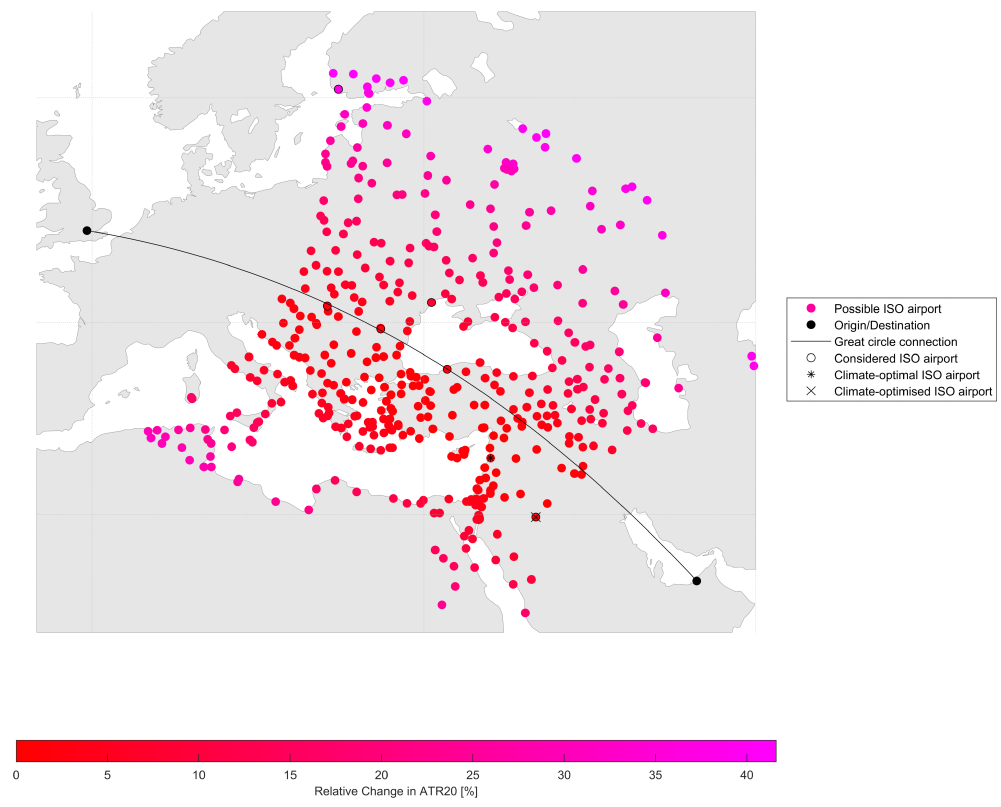
Figure A1. Possible intermediate stop airports for a flight from LHR to AUH with an Airbus A380 and the associated relative change in ATR20 compared to the climate-optimal